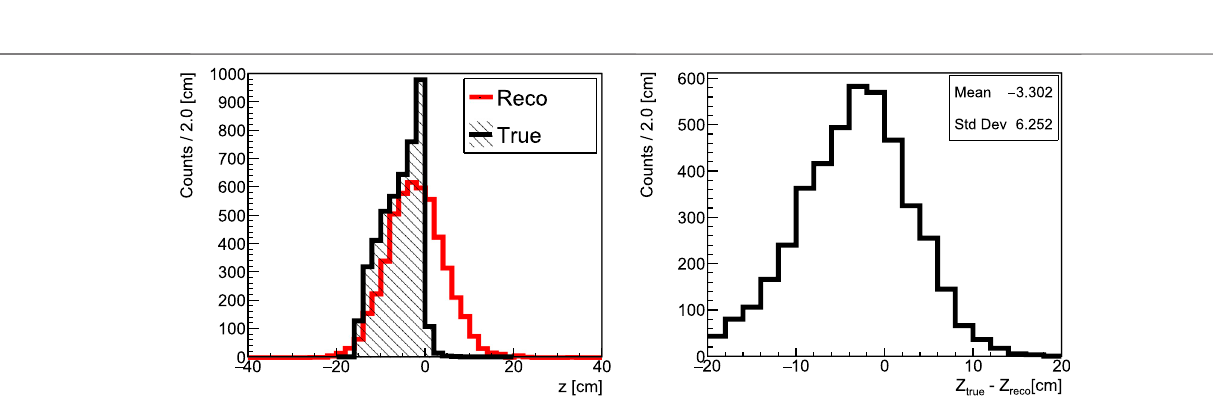
Frontiers in Physics |